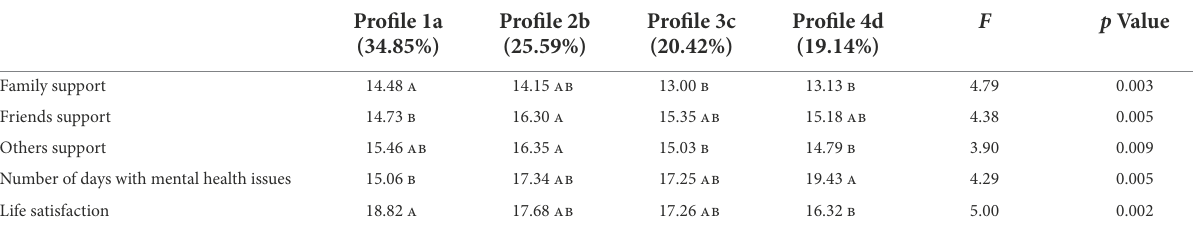
TABLE 4 Average scores ( z -scores) by profile for perceived social support, number of days with mental health issues in the last month, and life